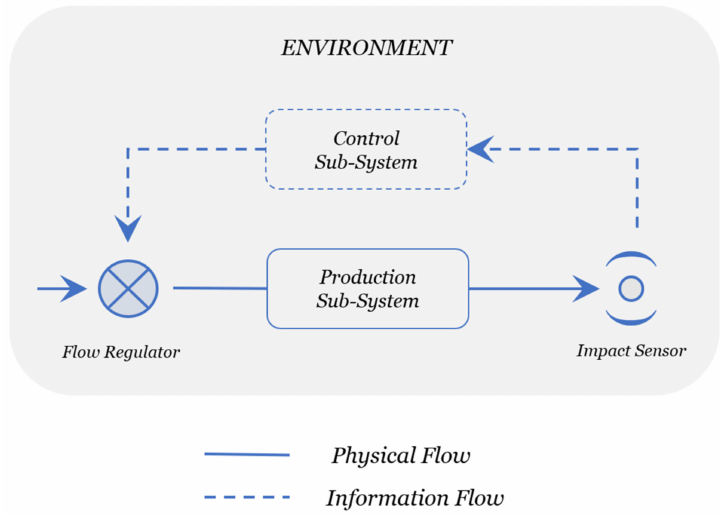
Figure 1. First-order Control